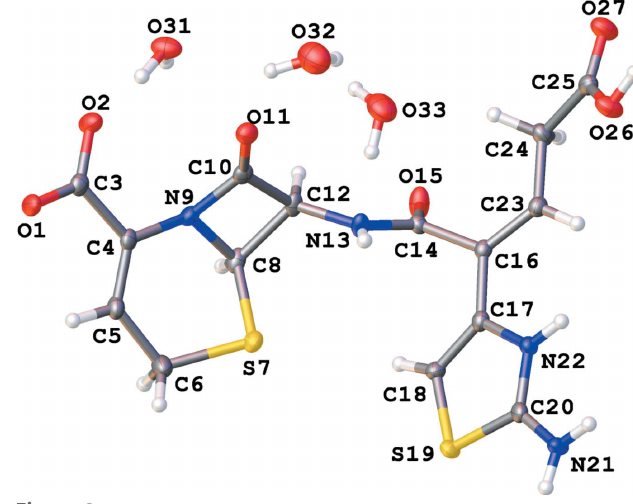
Figure 1 Molecular structure of (I). Ellipsoids of non-H elements are drawn at 50% probability.